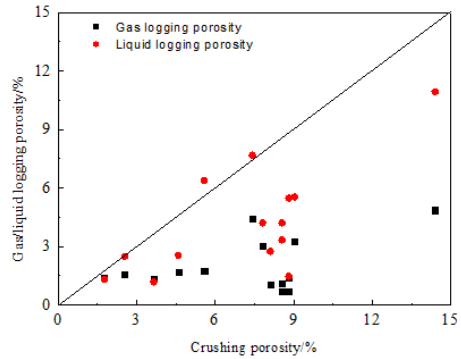
Figure 3. Crushing porosity vs. gas/liquid logging porosity.